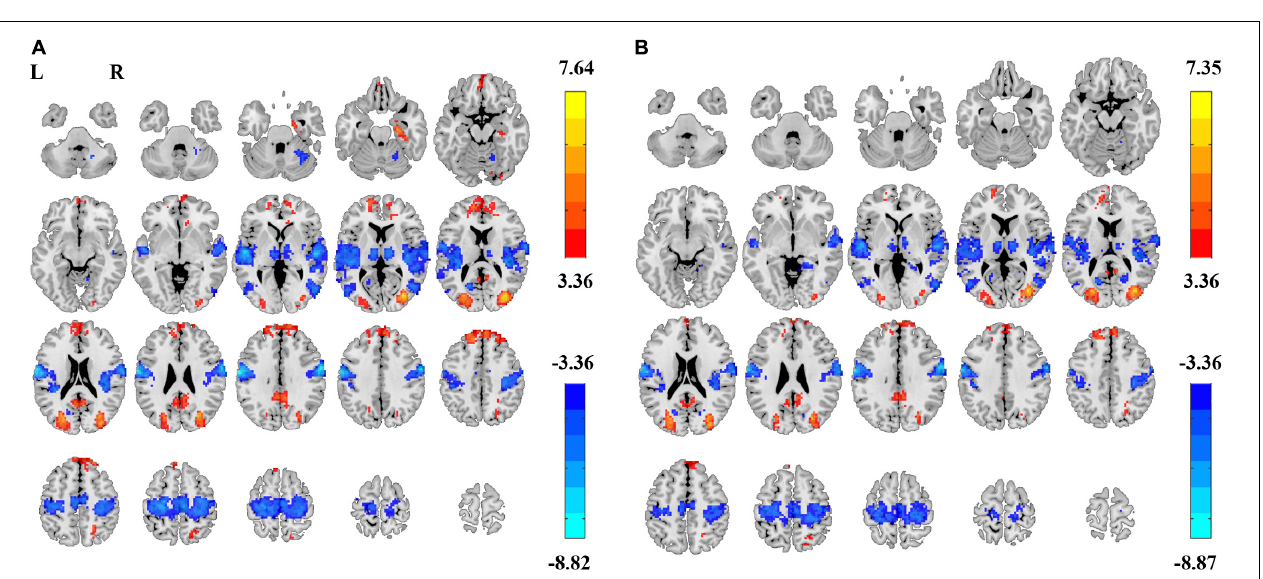
FIGURE 7 | PSS differences between EC and EO conditions using individual-level Z-transformed coefficient b and power-law slope b’. Significant difference between EC and EO conditions using individual-level Z-transformed coefficient b [Panel (A) , GRF correction, P corrected < 0.05, |T| > 3.36, cluster size > 75 voxels] and using power-law slope b’ [Panel (B) , GRF correction, P corrected < 0.05, |T| > 3.36, cluster size > 51 voxels]. L, left; R,